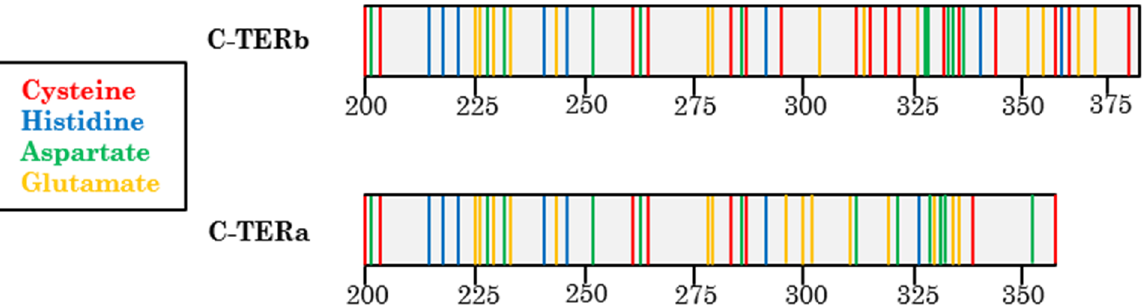
Figure 12. Sequence distribution of amino acids involved in metal binding in C ‐ TERb ( upper panel) and C-TERa ( lower panel). Selected residues are the most statistically represented in metal-bound proteins, which include cysteine (Cys), histidine (His), aspartate (Asp), and glutamate (Glu). Cys (red), His (blue), Asp (green), and Glu (yellow) residues are shown as sticks in their associated colour.